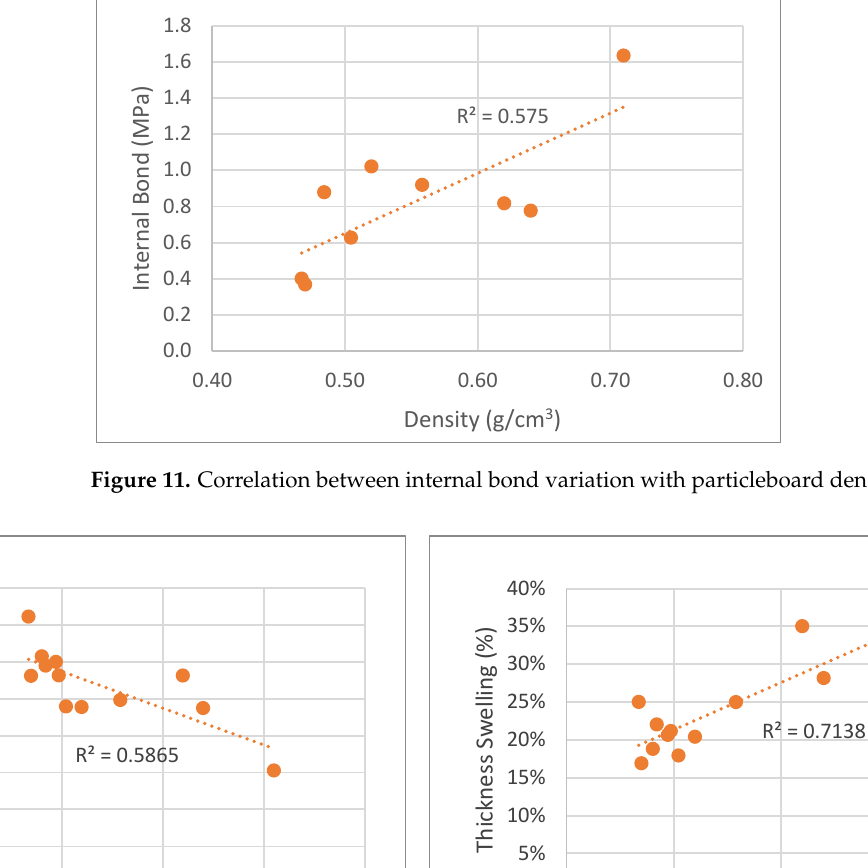
Figure 10. Correlation between bending strength and MOE variation with particleboard density. Figure 11. Correlation between internal bond variation with particleboard density.